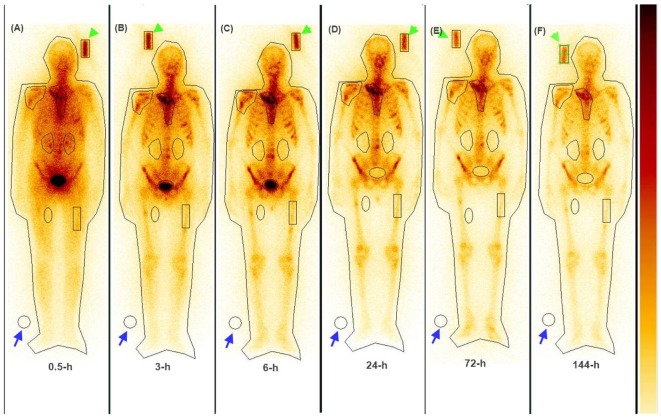
The whole body anterior images acquired using a dual head gamma camera at 0.5, 3, 6, 24, 72, and 144 h (A–F) following intravenous administration of 177Lu-EDTMP demonstrating intense localization of the tracer in bone metastatic sites.